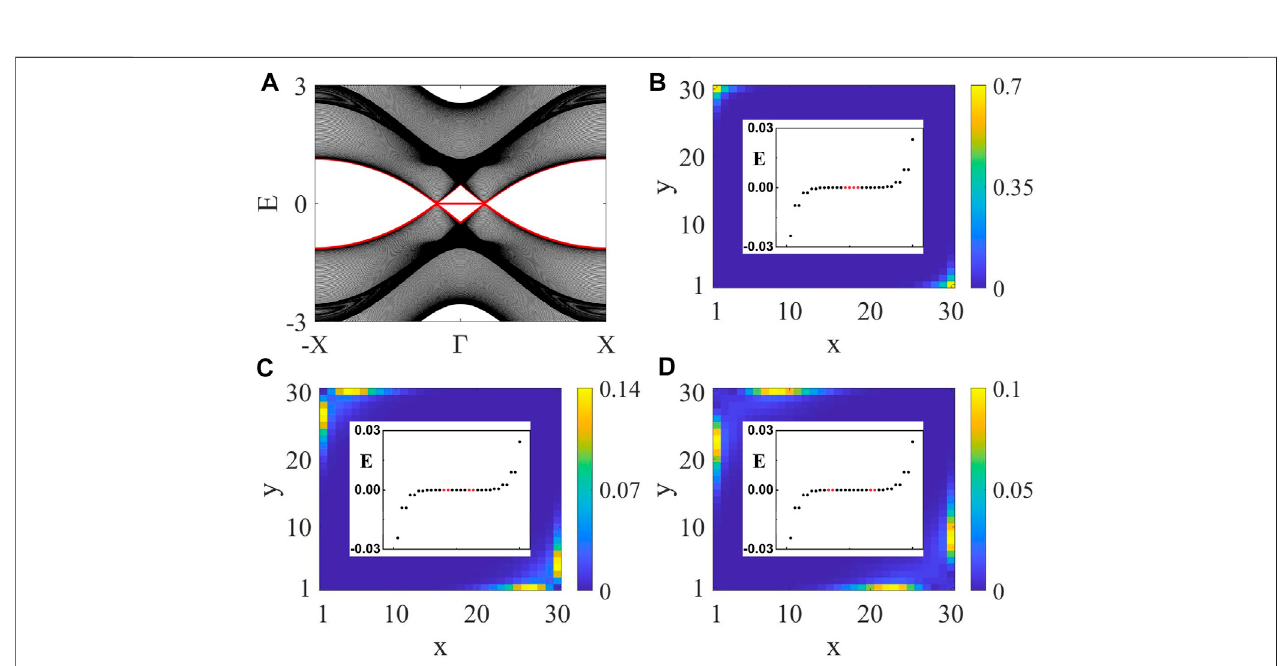
FIGURE5| (Coloronline)Topologicalsemimetalphasesinducedbyanin-planeferromagnetic-typeZeeman fi eld.Chosenparametersare: t =1, m =1.8, λ =1, η = 0.2, B x = B y = 0.5. (A) N y = 100, the energy spectrum under a cylindrical geometry shows the existence of fl at-band edge states. Under an open-square geometry, (B) showsthattheprobabilitydensitypro fi lesofthefourmiddleeigenstates(thefourreddotsintheinset)aresharplylocalizedatthecornerseventhoughthebulkisgapless. (C) and (D) show the probability density pro fi les of some other eigenstates (also highlighted by red dots) with energies close to zero.